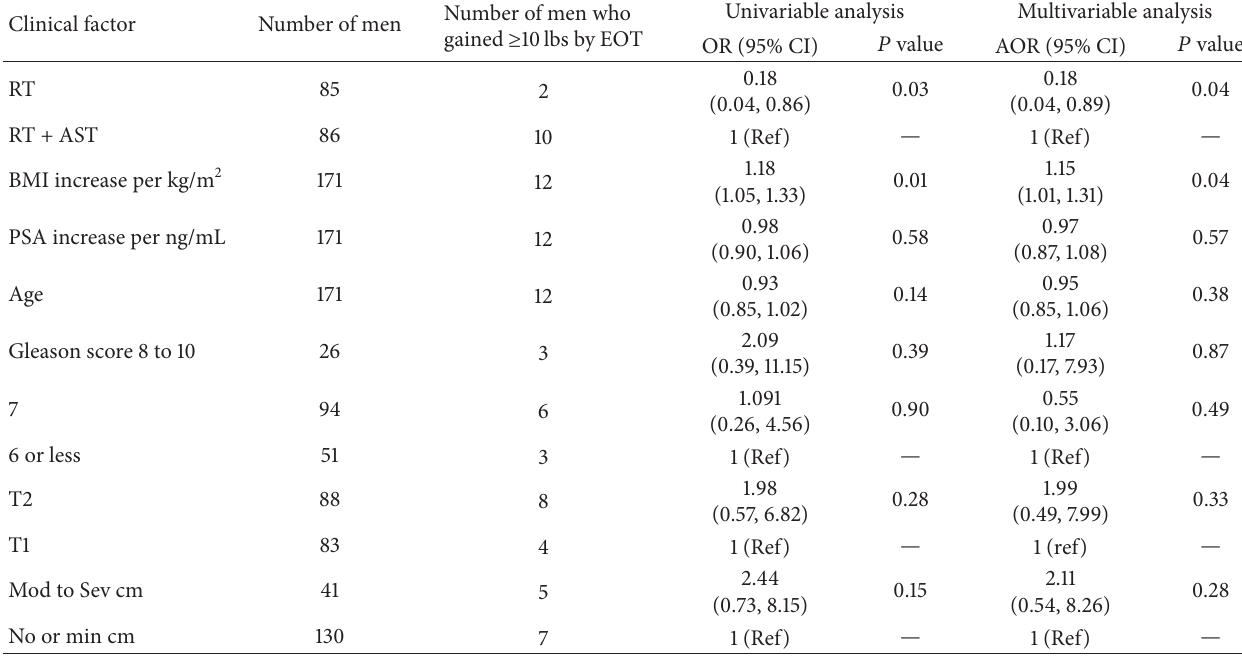
Table 2: Univariate and multivariate odds ratios for the risk of ≥ 10lbs weight gain 6 months after randomization for each clinical factor. Clinical factor Number of